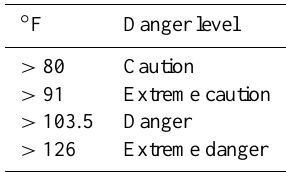
Table 1. Heat index danger levels according to National Weather Service